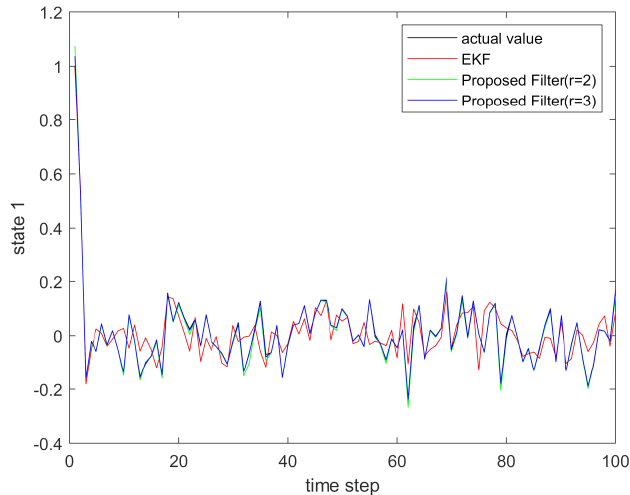
Figure 5. The actual value of state 1 and its estimation.